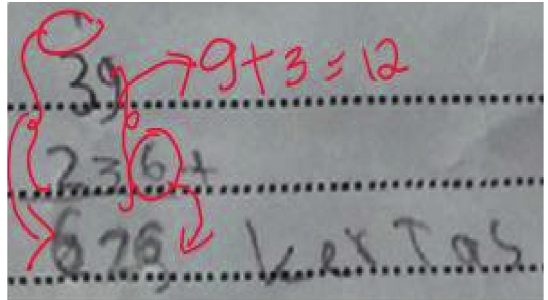
Figure 7: Student’s answer using short-complex addition